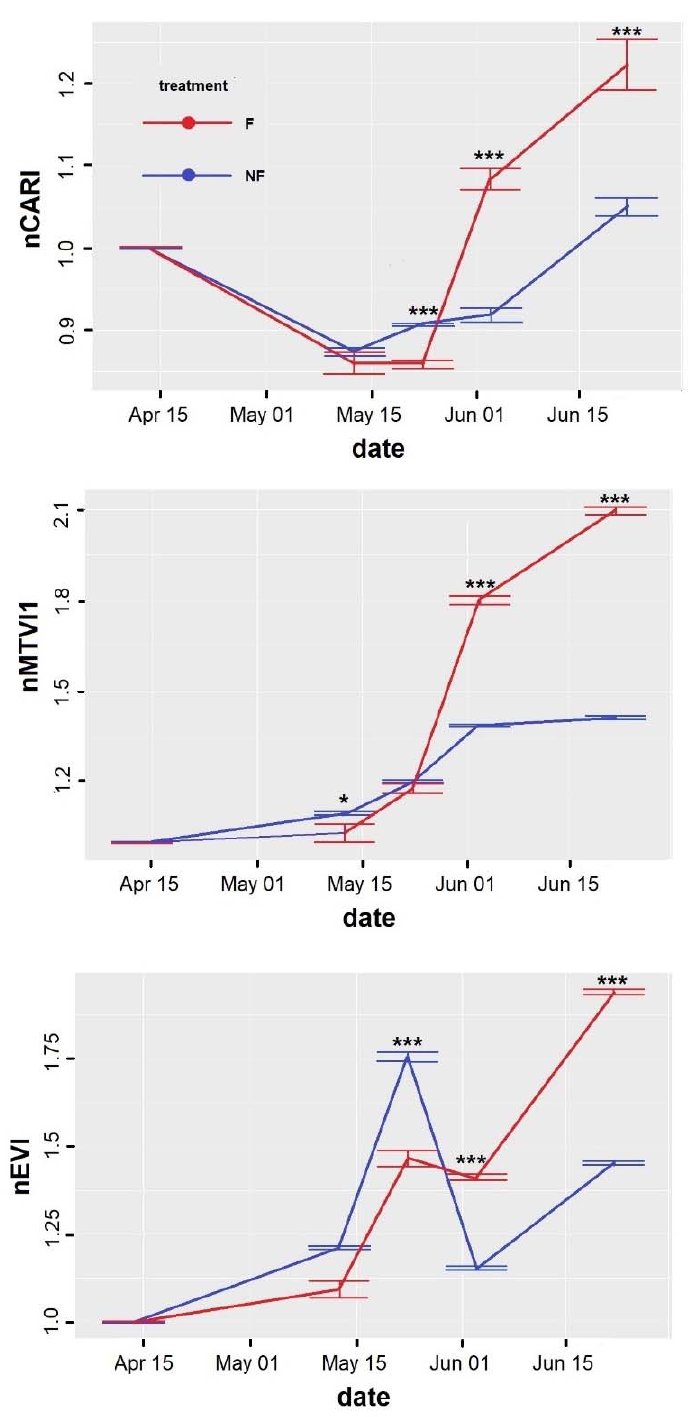
Figure 4. Change of normalized CARI, MTVI1, and EVI from May to June 2017. The values reported in y axis represent the reflectance values normalized on the first date, equating to 1. Statistical significance was determined by Student’s t -test. Single asterisk indicates a significant di ff erence between treatments, p < 0.05; double asterisk indicates a statistical di ff erence, p < 0.01; triple asterisk indicates a statistical di ff erence, p < 0.001 (unpaired t -test). Error bars represent standard error of the mean.